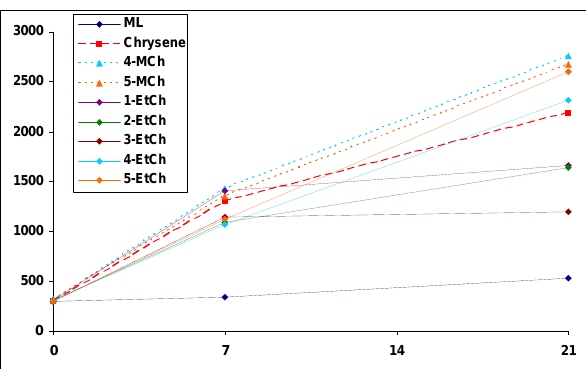
Figure 4: Induction of lipid peroxidation by photoirration of chrysene and its methylated and ethylated derivatives by UVA